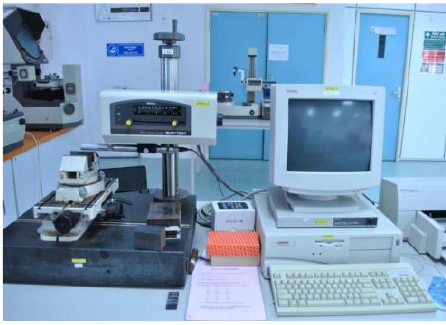
Figure 3: Experimental setup of the work-piece on DMU 35M Deckel Maho milling Machine.